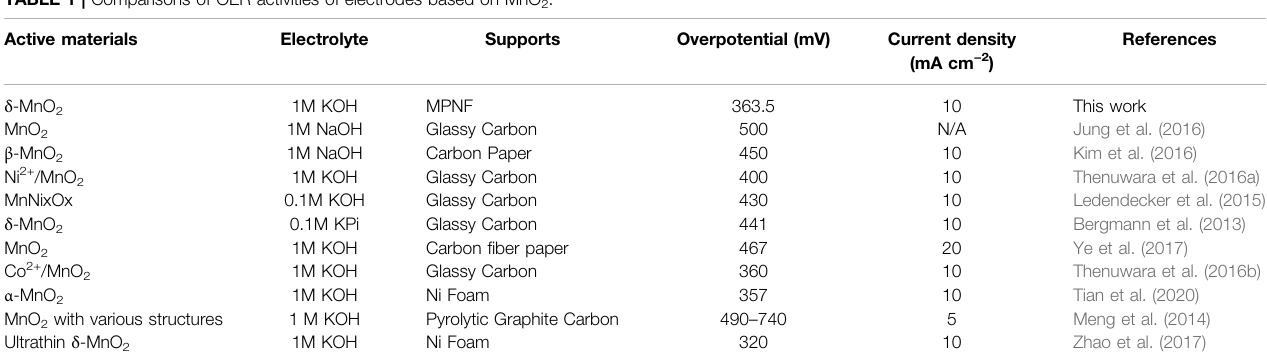
TABLE 1 | Comparisons of OER activities of electrodes based on MnO 2 . Active materials Electrolyte